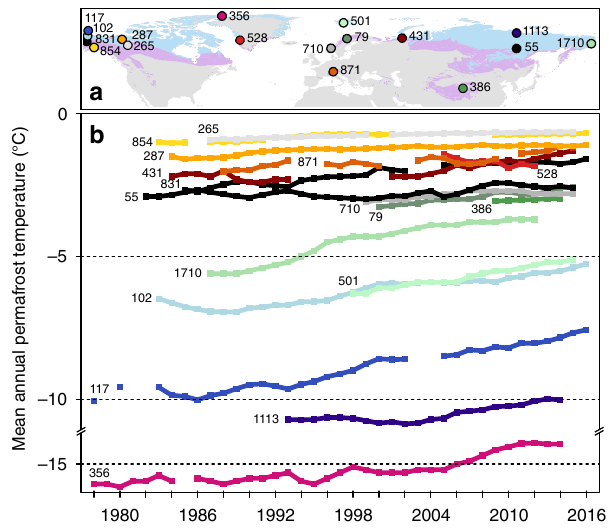
Fig. 1 Long permafrost temperature records for selected sites. a Location of boreholes with long time-series data. Because some regions lack long temperature records, shorter temperature records from Greenland and Chinese mountains are included for comparison. Depth of measurements is according to the Global Terrestrial Network for Permafrost ID 16 : 24.4 m (ID 356), 20m (ID 55, 79, 102, 117, 501, 710, 831, 1113, and 1710), 18m (ID 386), 16.75 m (ID 871), 15m (ID 854), 12m (ID 287), 10m (ID 265, 431), and 5m (ID 528). The light blue area represents the continuous permafrost zone (>90% coverage) and the light purple area represents the discontinuous permafrost zones (<90% coverage). b Mean annual ground temperature over time. Colors indicate the location of the boreholes in a. Permafrost zones are derived from the International Permafrost Association (IPA) map 46 . World Borders data are derived from http://thematicmapping.org/ downloads/world_borders.php and licensed under CC BY-SA 3.0 (https://